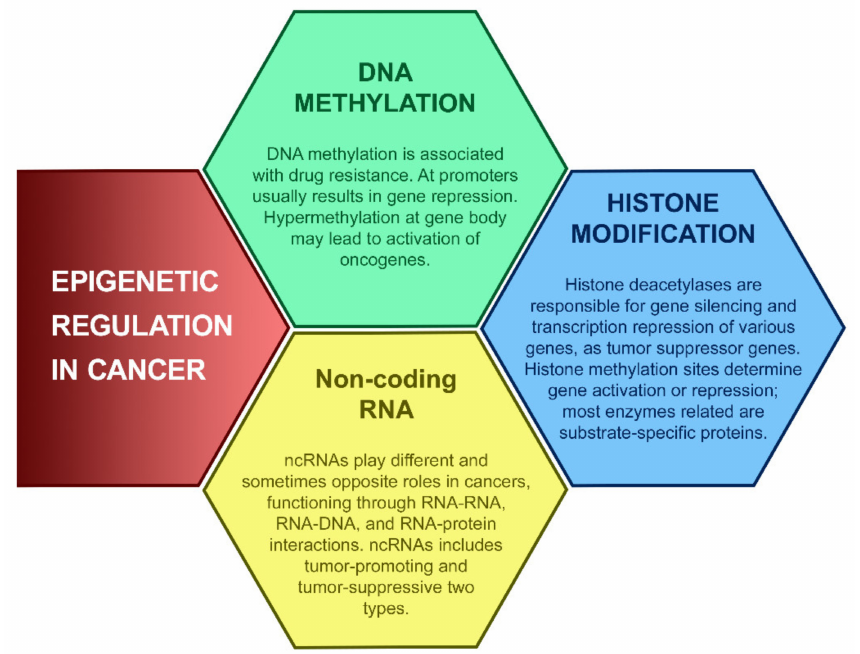
Figure 2. Epigenetic regulations in cancer. Alterations in epigenetic modifications in cancer regulate various cellular responses, including cell proliferation, apoptosis, invasion, and senescence. Through DNA methylation, histone modification, and noncoding RNA regulation, epigenetics play an im- portant role in tumorigenesis. These main aspects of epigenetics present reversible effects on gene silencing and activation via epigenetic enzymes and related